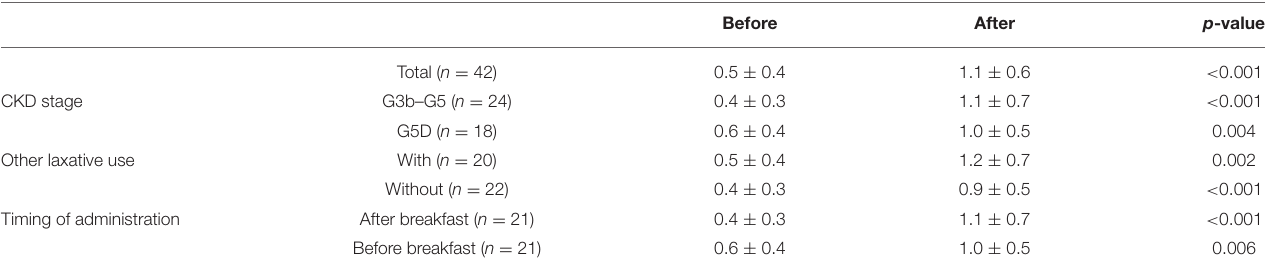
TABLE 2 | Stool frequency (times per day) before and after 1 week of elobixibat administration according to CKD stage, concomitant laxative use, and timing of administration.